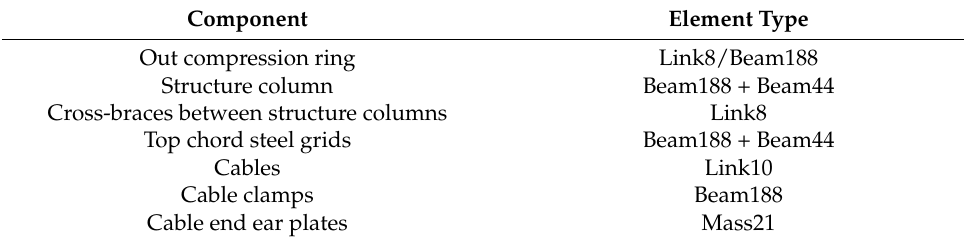
Table 2. Element types.